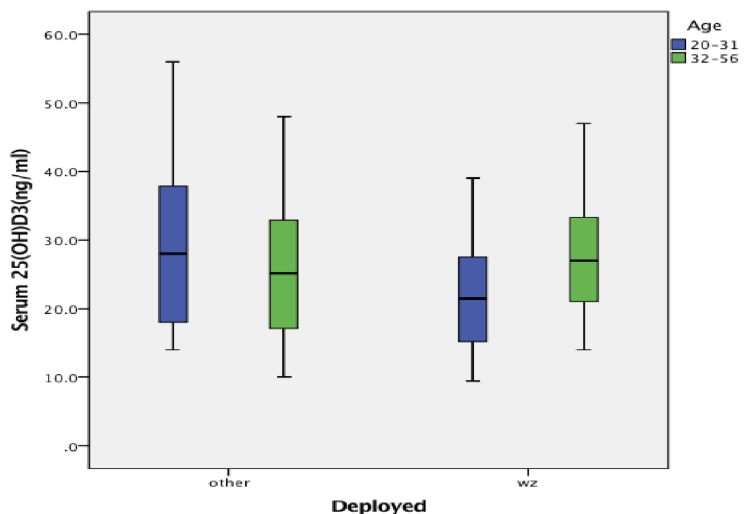
Figure 1. Seasonally adjusted serum 25(OH)D 3 (ng / mL) levels drawn from the U.S. Marines. Table 1. Mean seasonally adjusted serum 25(OH)D 3 ng/mL levels drawn from groups of U.S. Deployed Marines.